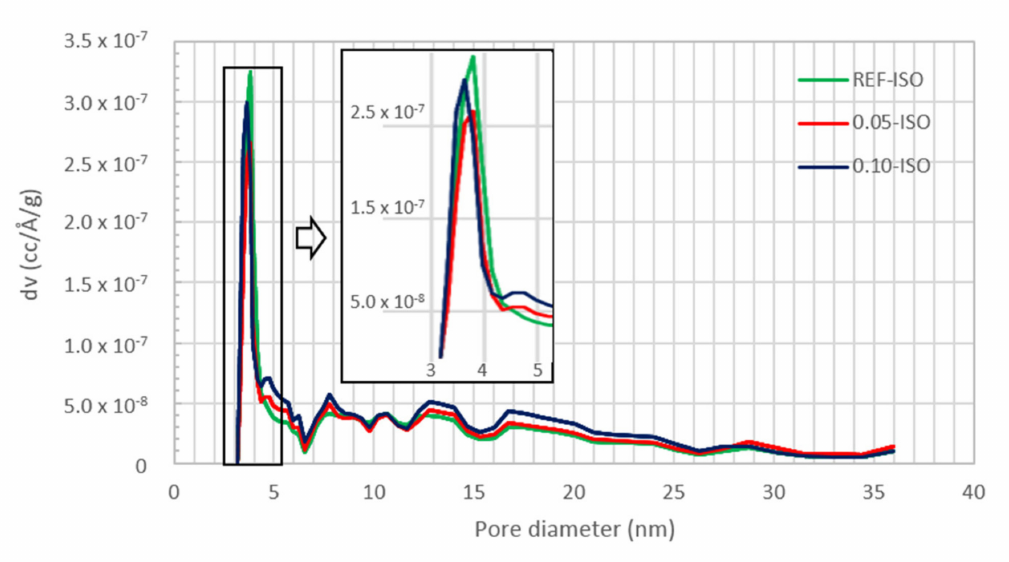
Figure11. Poresizedistributionofcementpasteobtainedbythedensityfunctionaltheory(DFT)method.